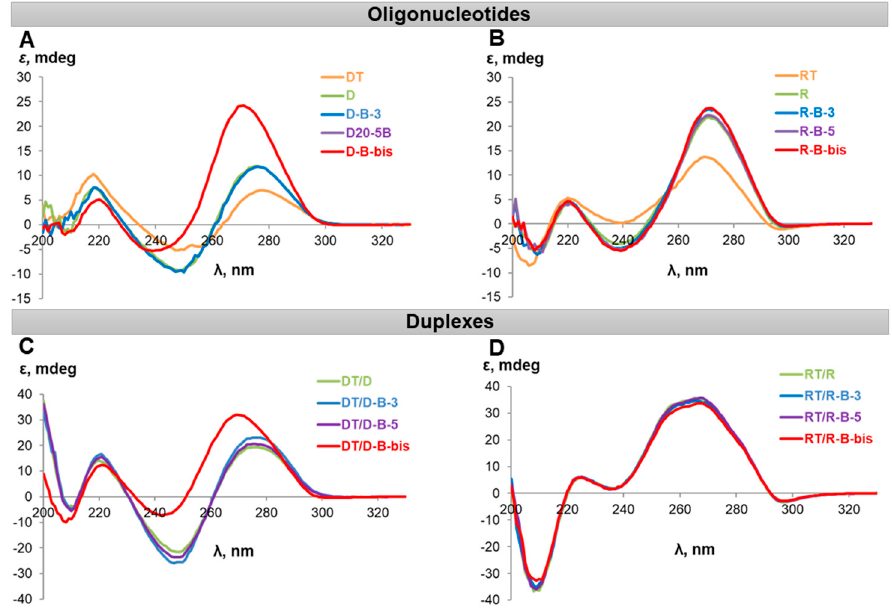
Figure 8. Circular dichroism (CD) spectra of boron cluster-modified oligonucleotides ( A , B ) and their duplexes ( C , D ) with complementary strands. ( A ) Spectra of oligodeoxyribonucleotides; ( B ) spectra of oligoribonucleotides; ( C ) spectra of DNA duplexes; ( D ) spectra of RNA duplexes. Conditions: 25 °C, 10 mM sodium phosphate (pH 7.5), 100 µM oligonucleotides.